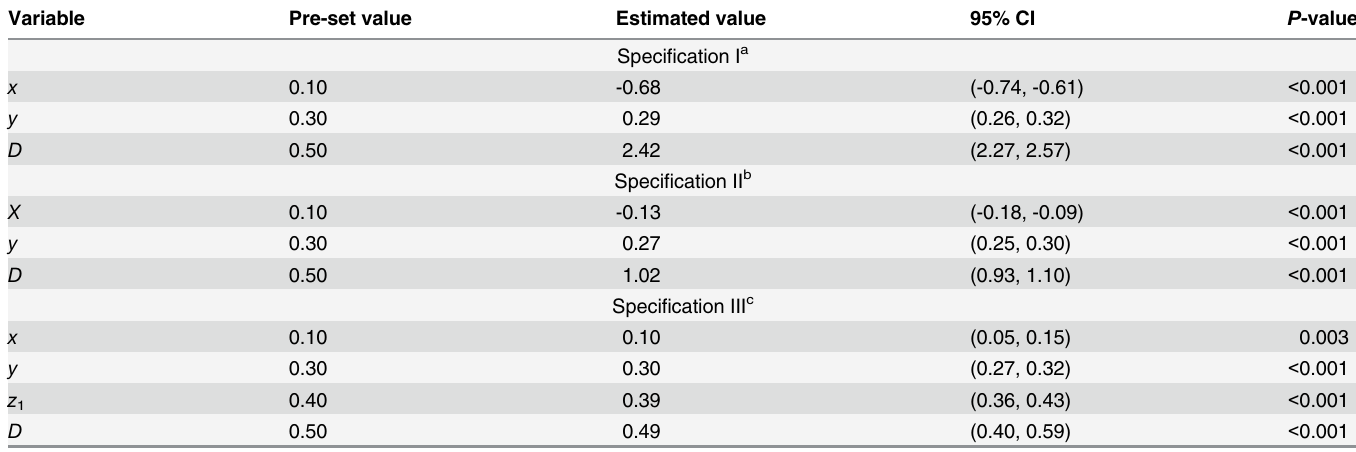
Table 2. Stage-II estimates of the coefficient for each of the variables (x, y, D) included in the Cox proportional hazard models for different specifi- cations, Monte Carlo simulations, sample size 5000, d 1 = 0.2 and δ 1 = 0.4.